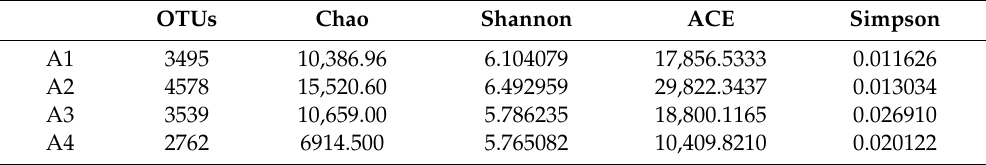
Table 2. Analysis of diversities according to high-throughput sequencing.